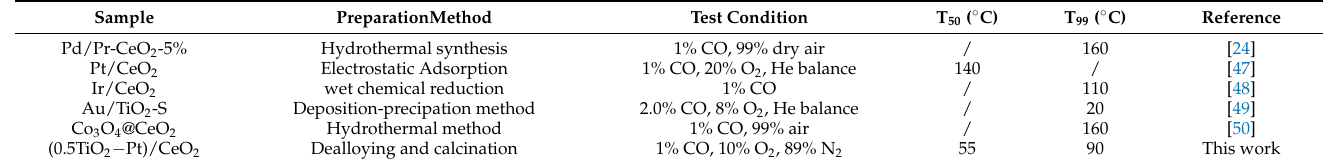
Table 1. Comparison on catalytic performance of (0.5TiO 2 − Pt)/CeO 2 with previous reports.